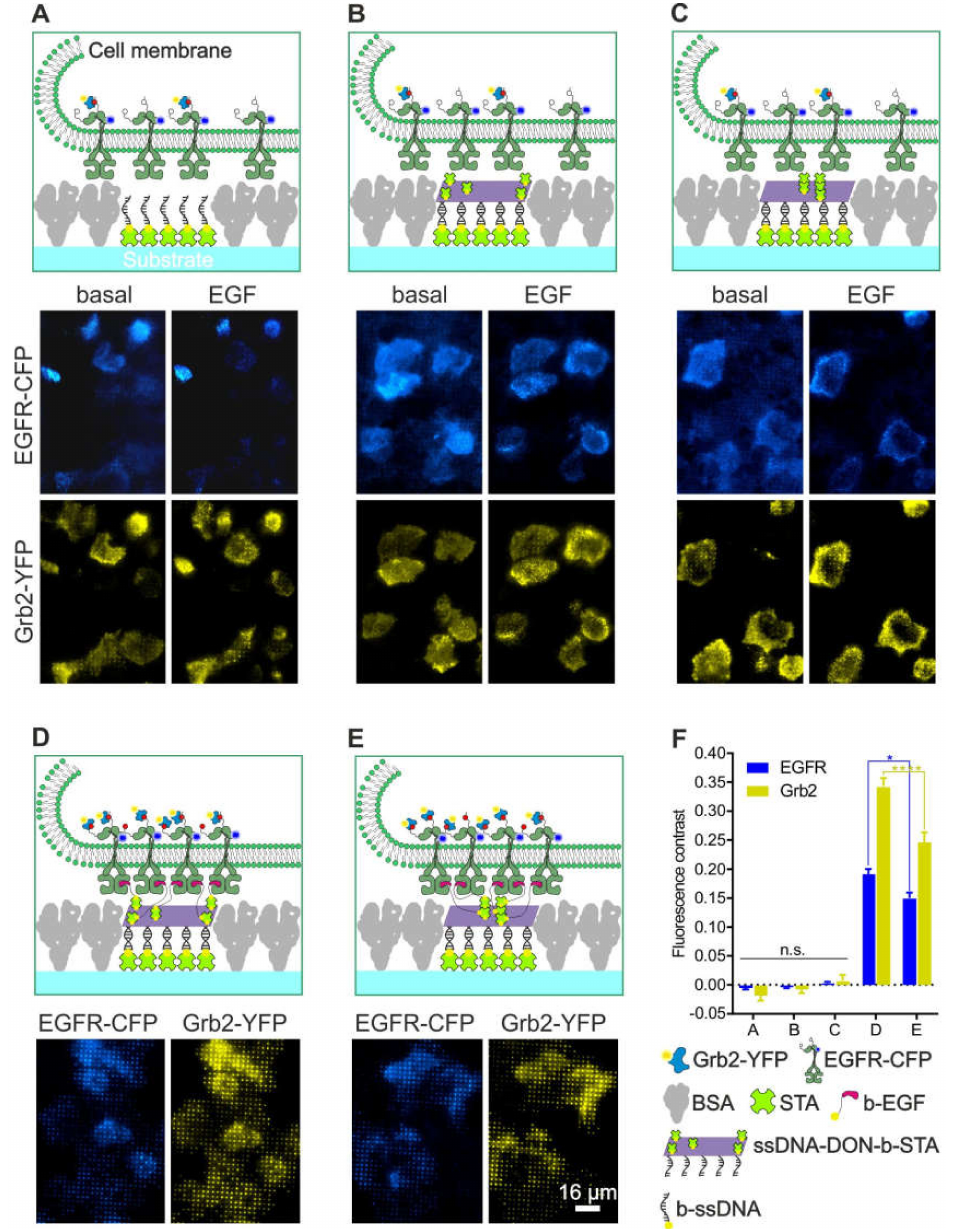
Figure 6. Impact of the degree of surface functionalization on the specificity of bait (EGFR) and prey (Grb2) enrichment using a DNA origami approach. HeLa cells transiently co-expressing EGFR-CFP and Grb2-YFP were grown on 1- µ m BSA grids consisting of di ff erent surface chemistry as in ( A ) single-stranded oligonucleotides, ( B ) hybridized DONs decorated with the 5far arrangement of STA, ( C ) chemistry as in B but with the 5close DON arrangement, ( D ) chemistry as in B but additionally modified with biotinylated EGF to mediate specific EGFR capturing and activation, ( E ) chemistry as shown in D but with 5close DON. Where applicable, the cells were stimulated with EGF (170 nM) for at least 5-10 min prior to imaging. ( F ) Quantitation of EGFR-CFP and Grb2-YFP fluorescence contrast of the cells grown on the substrates shown in A-E. Error bars are based on the mean ± SE of more than 150 cells. * p < 0.05 and **** p < 0.001 for comparisons of 5far and 5close DONs. Quantitation is based on Figure S2, Figure S3, Figure S4, Figure S5 and Figure S6. Abbreviations: BSA, bovine serum albumin; b-EGF, biotinylated EGF; b-ssDNA, biotinylated single-stranded DNA; STA, streptavidin; and ssDNA-DON-b-STA, single-stranded DON with biotin and streptavidin. Graphical illustrations are not drawn to